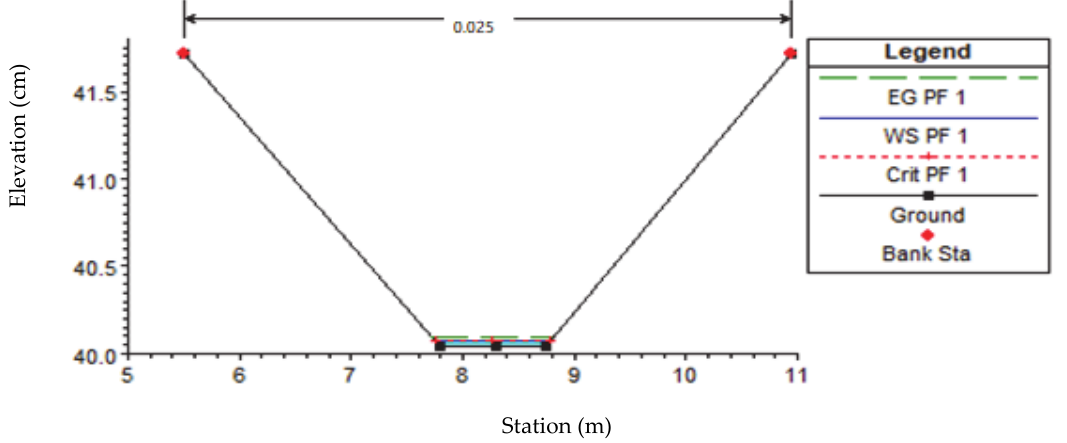
Figure 7. River cross ‐ section downstream with existing discharge.